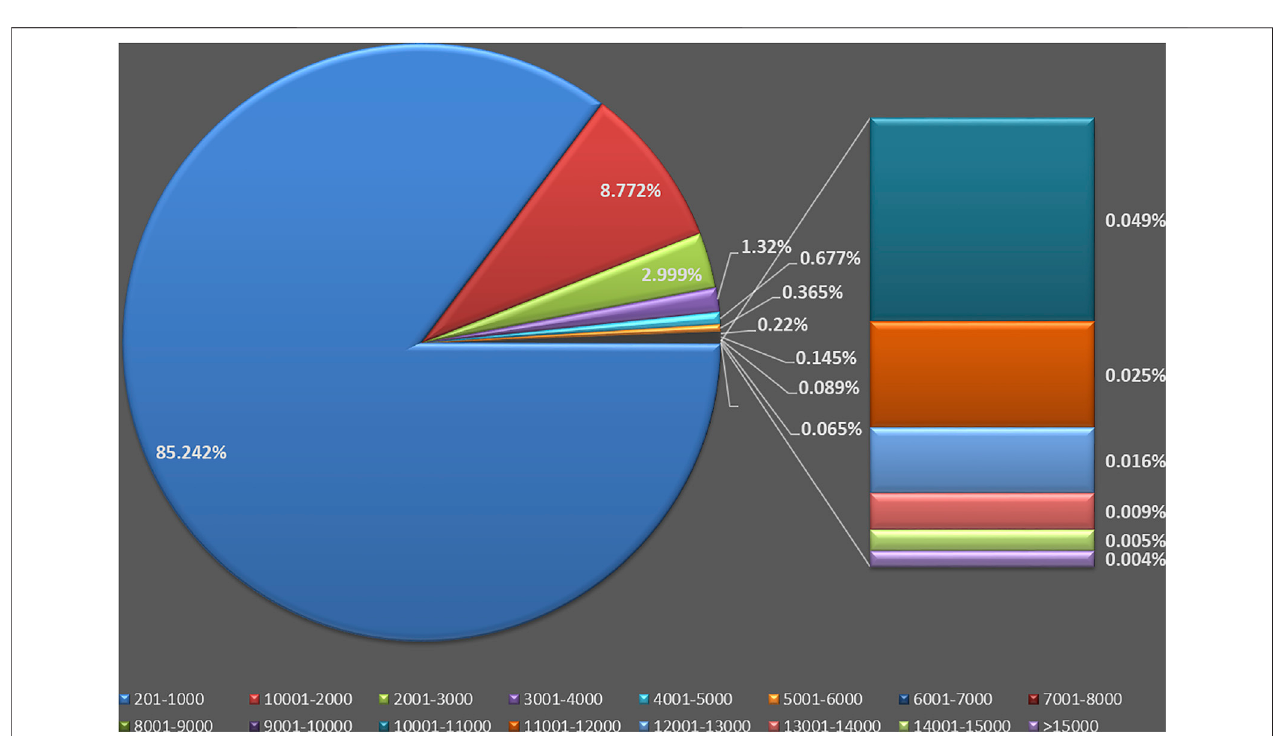
FIGURE 2 | Sequence length distribution of the assembled